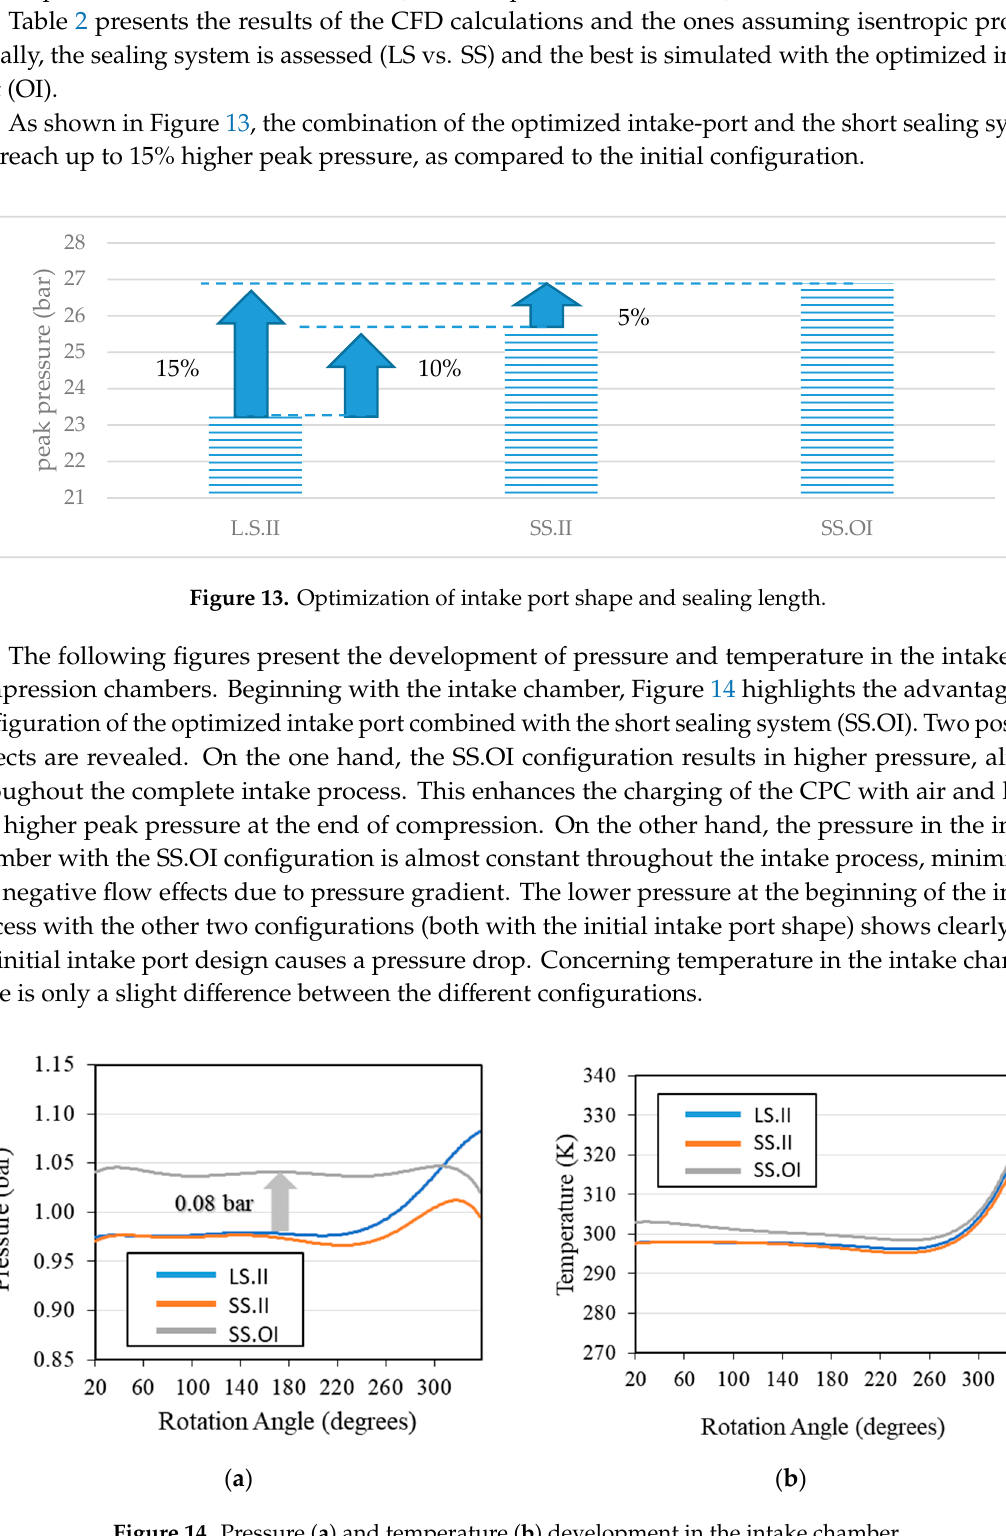
Table 2. Optimization of intake port and sealing system.